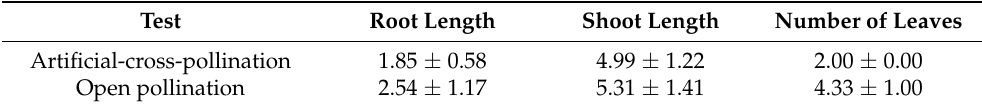
Figure 6. Growing rate, compared through the shoot length of newly germinated plants, was higher in the experiment of open pollination (natural pollination), (* p < 0.005). Table 4. Morphological data (average size ± standard deviation) of Ludwigia nervosa seedlings from seed germination test after specific pollination treatments. Measures in